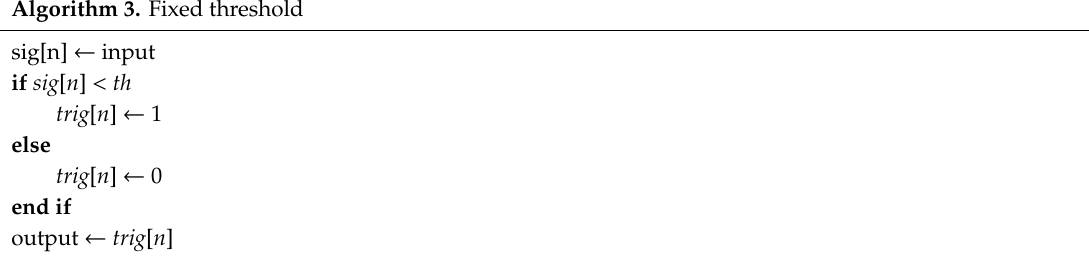
Algorithm 3. Fixed